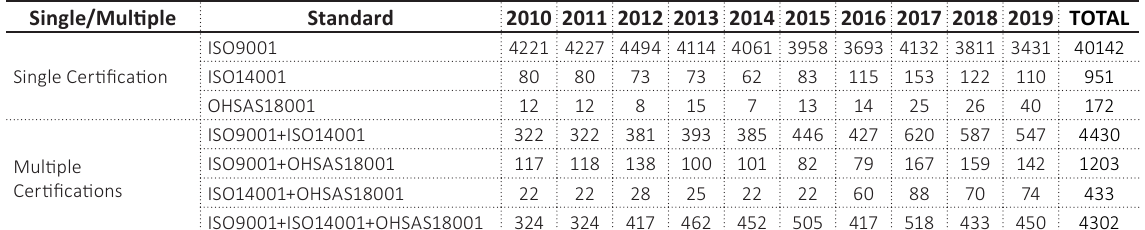
Table 1. Dynamics of certified companies